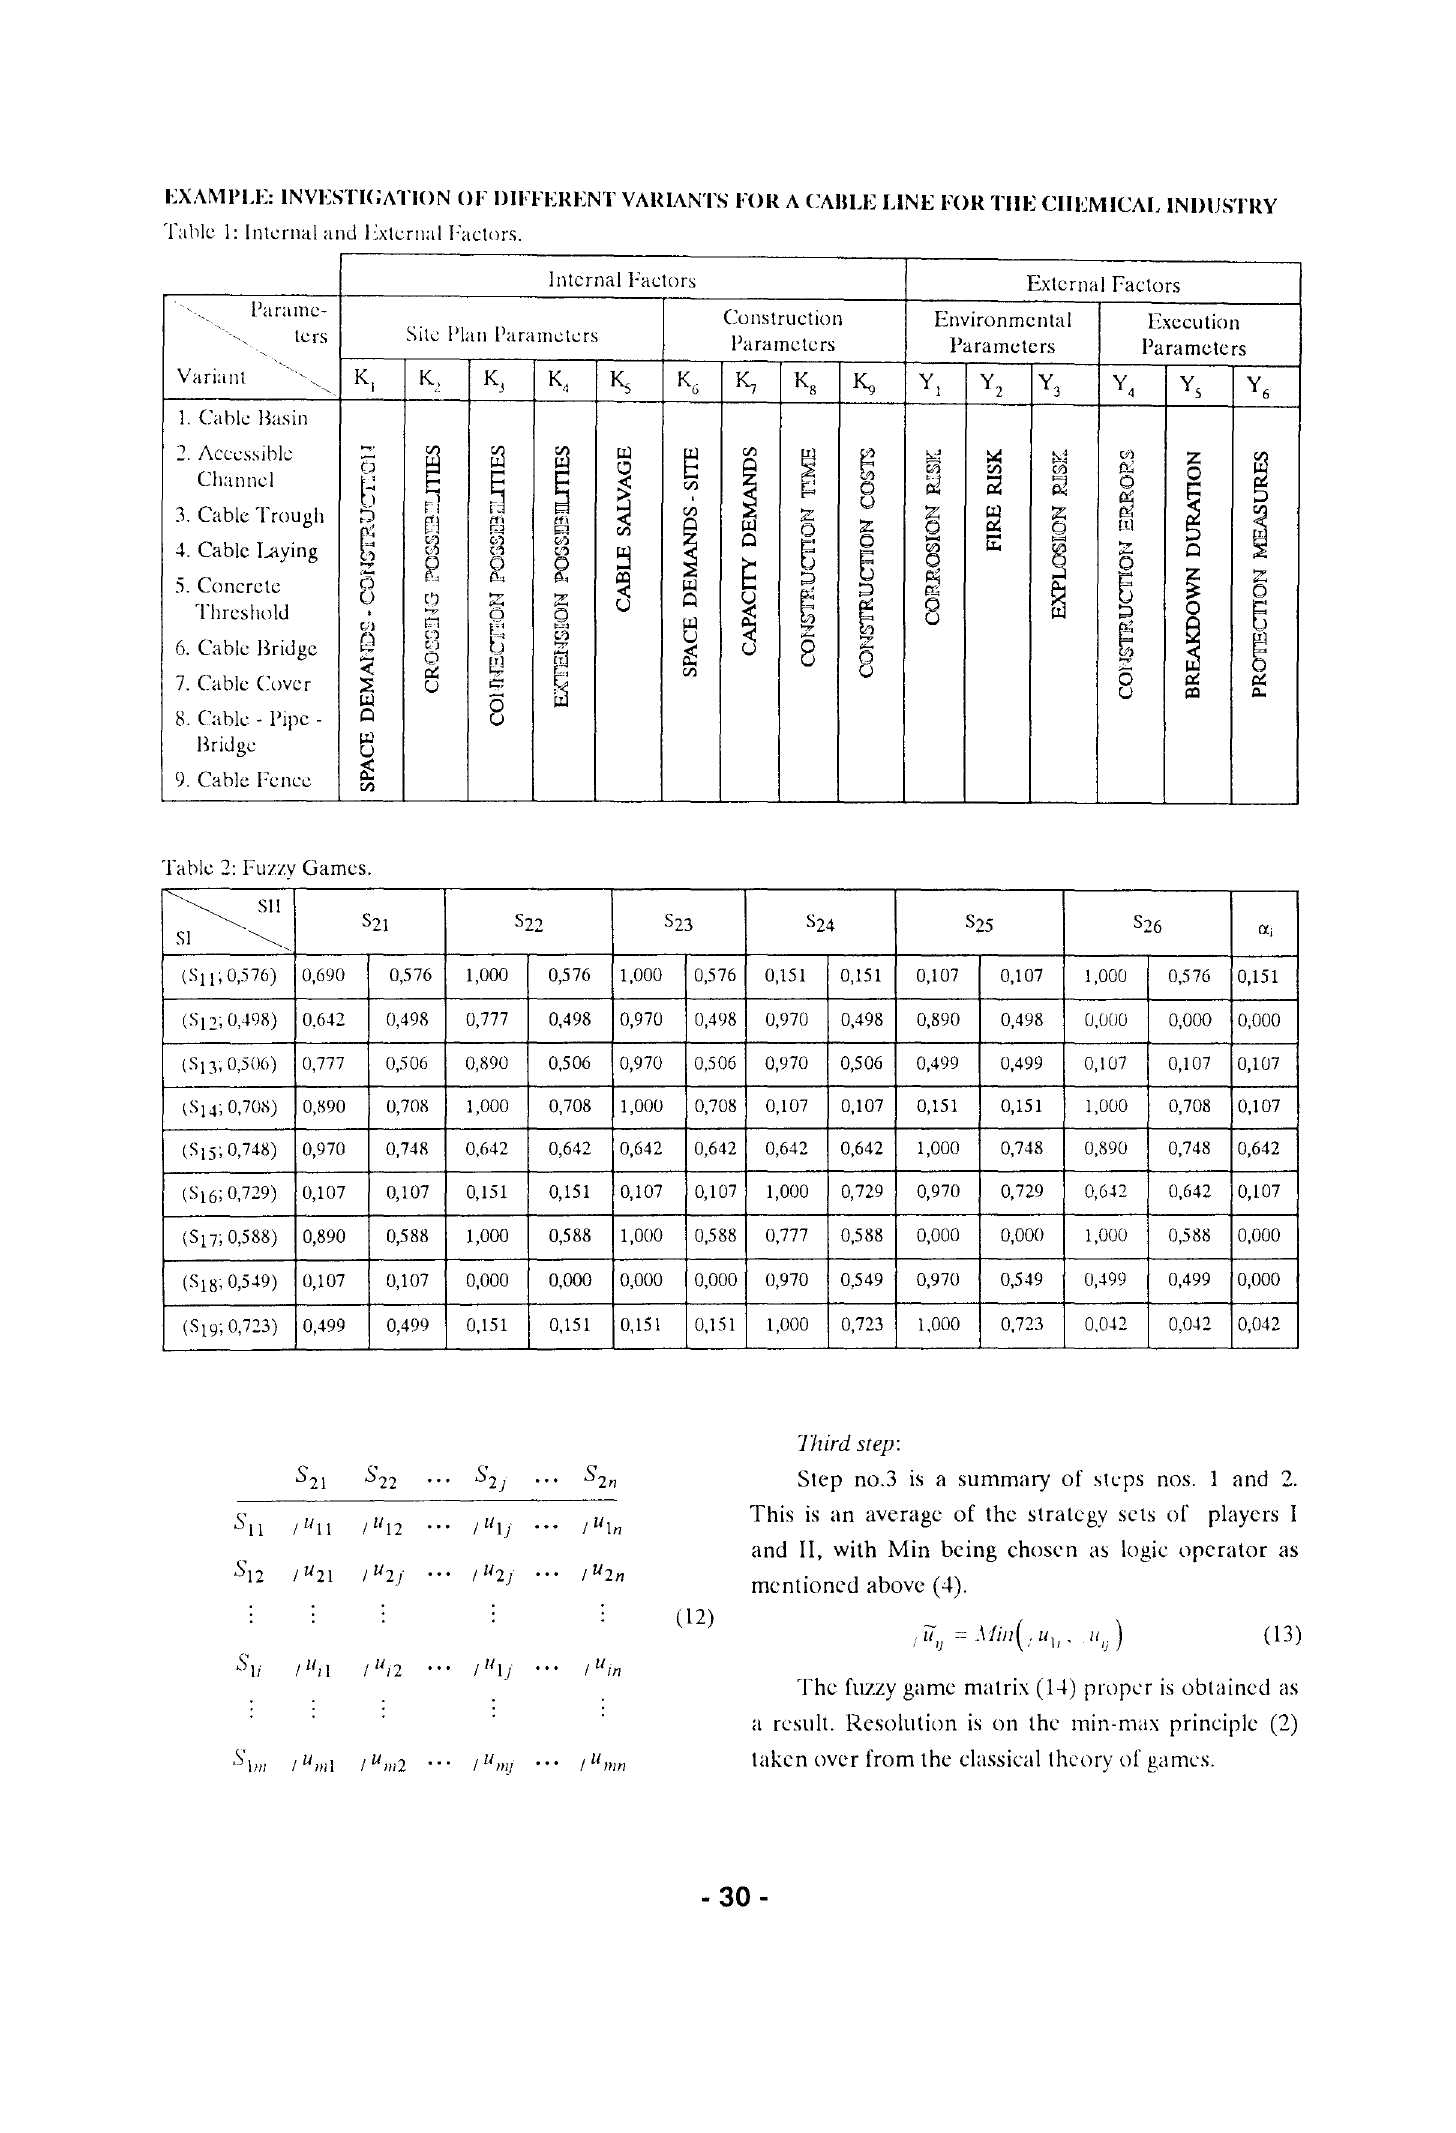
Table 1: lnh.:rnal and External Factors. .